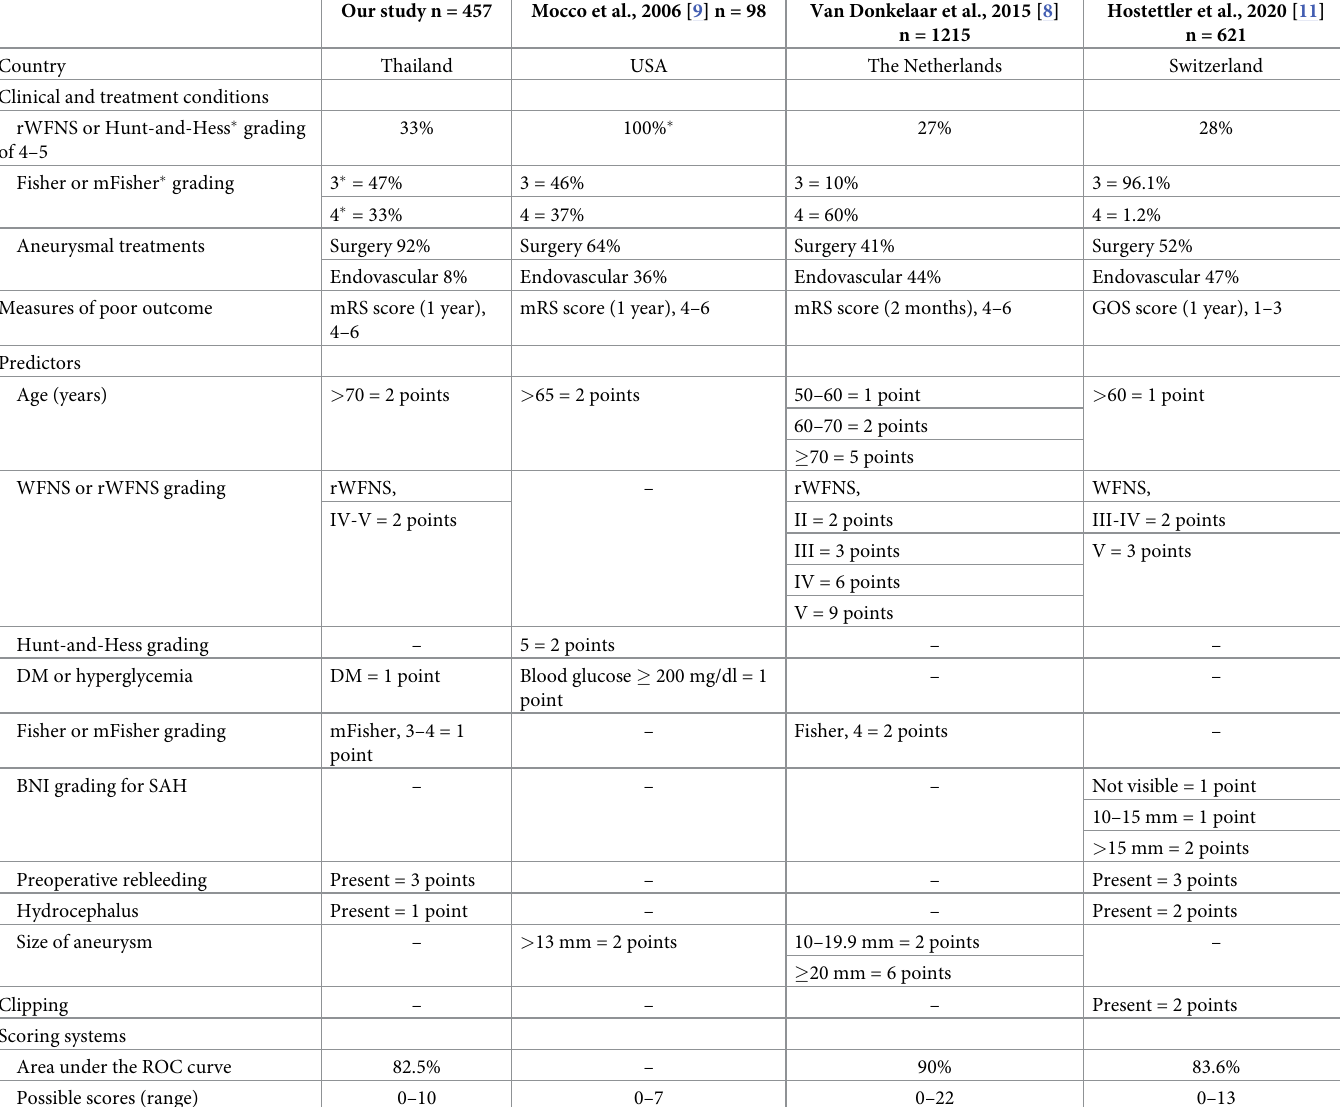
Table 4. Published scoring systems for the prediction of poor outcome in patients with aneurysmal